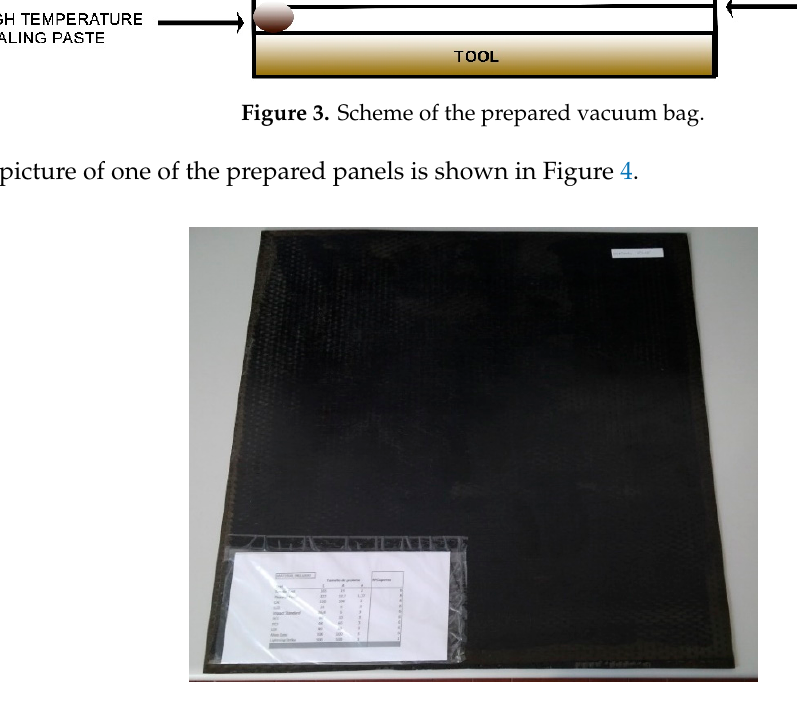
Figure 4. Picture of the manufactured panel.